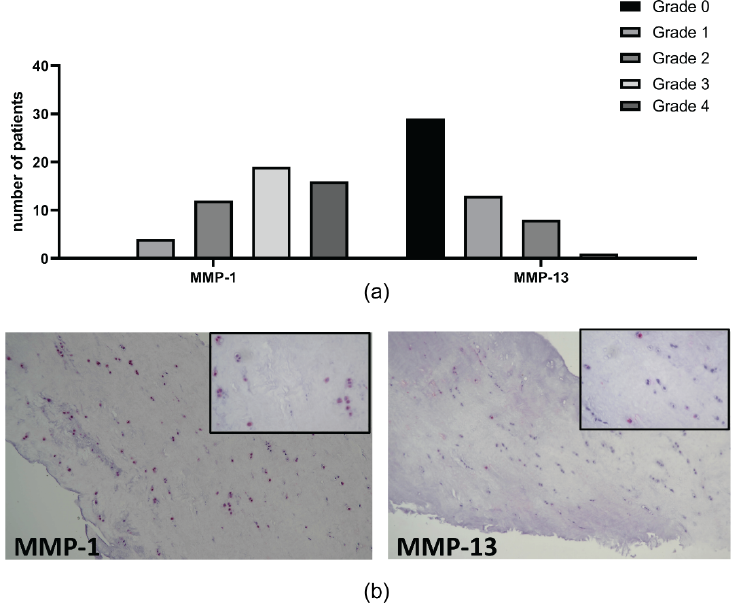
Figure 3. Immunohistochemistry of metalloproteinase in meniscal samples. ( a ) number of patients with different expression of MMP-1 and -13; ( b ) one representative patient for MMP-1 (grade 3) and MMP-13 (grade 1), (magnification 10 × , inset 40 × ,